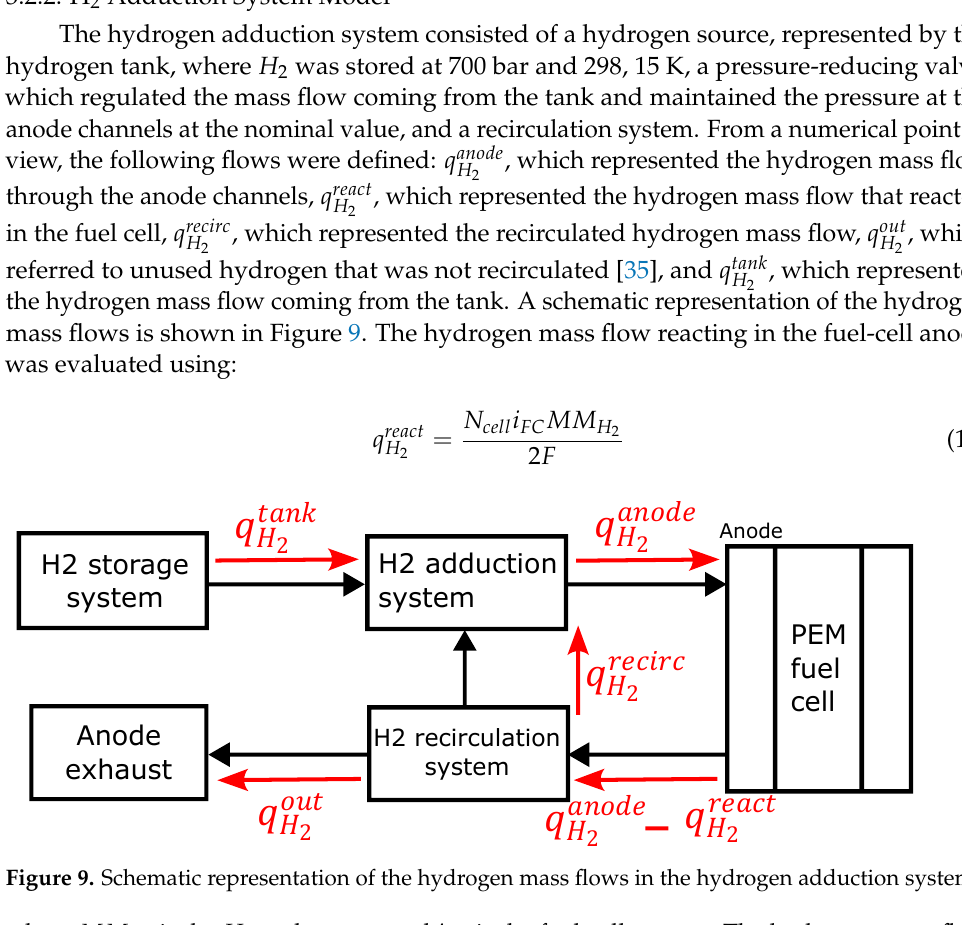
Figure 8. Cell voltage and power density curves as functions of current density.